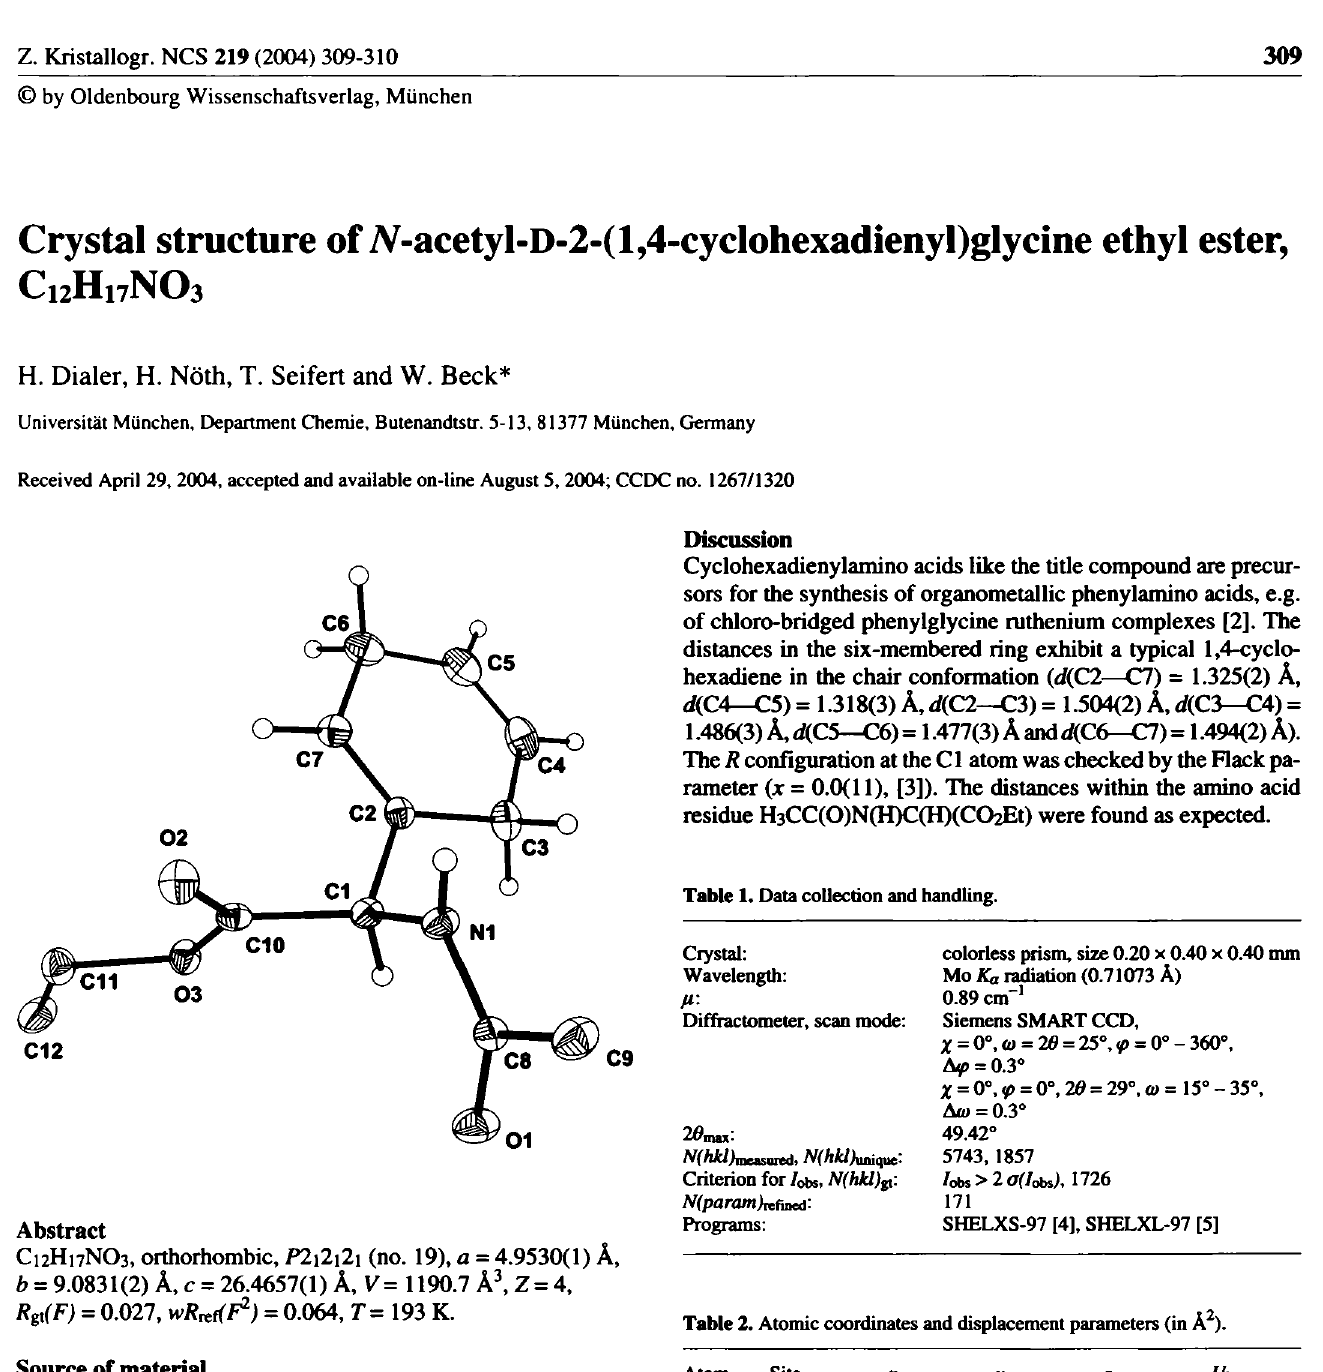
Table 2. Atomic coordinates and displacement parameters (in Â 2